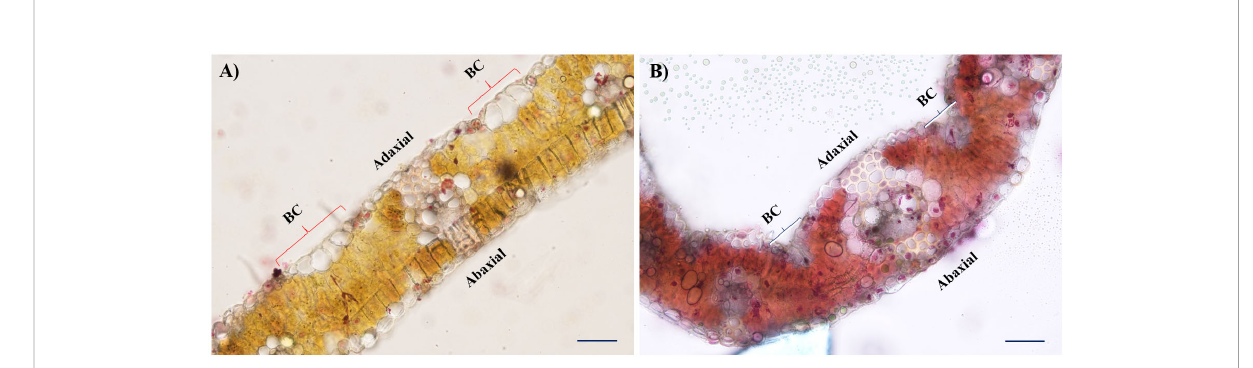
FIGURE 2 Histological observation of fl ag leaves contrasting in their propensity for bulliform cells (BC) activity in leaf rolling under moisture stress. (A) Cross-sections of RIL D-65 under irrigated condition, and (B) Cross-sections of drought treated RIL (D-65) leaves under 20X resolution. Scale bars: 50 µm.